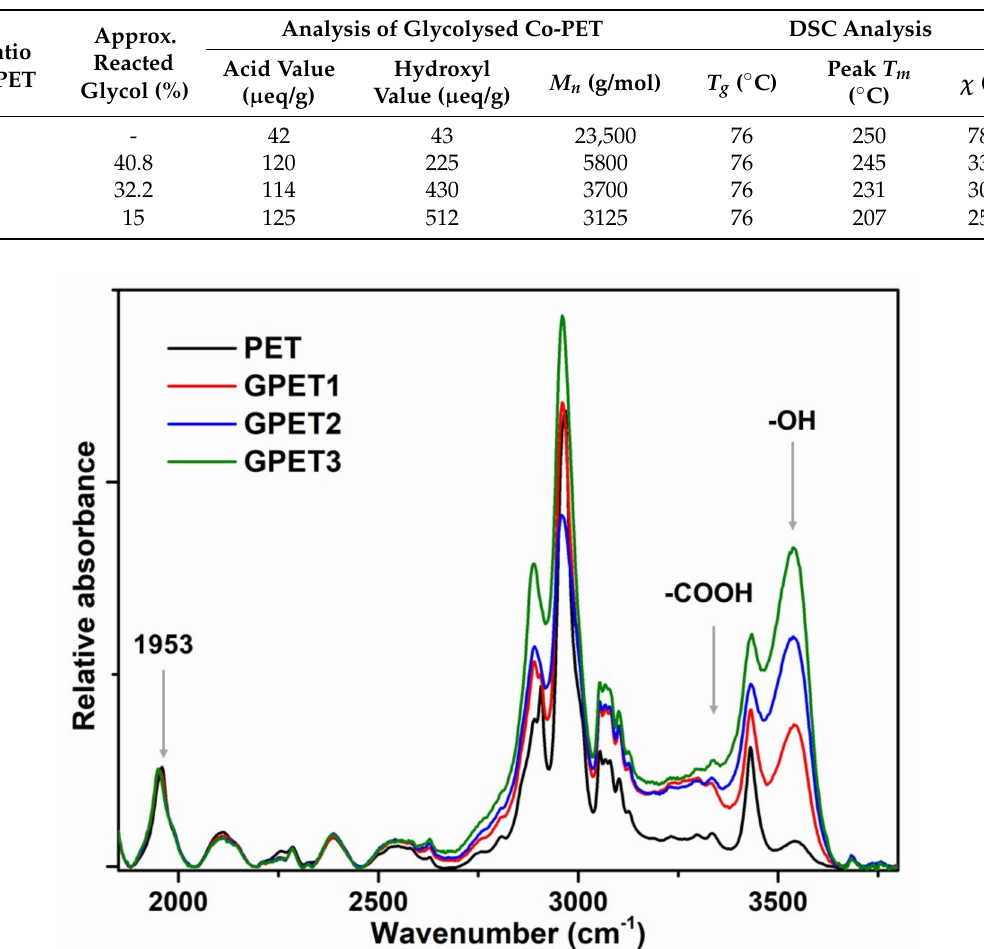
Table 1. Glycolysis parameters and corresponding FTIR and DSC analyses.